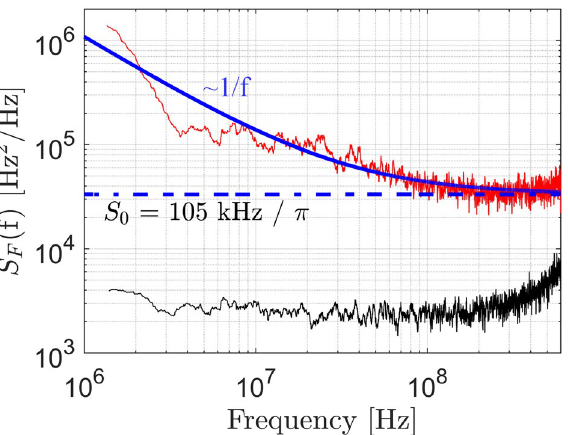
Figure 6. FM-noise spectrum and linewidth measurement. The FM-noise spectrum of the ECL is obtained through heterodyne detection with a narrow-band reference LO laser (Keysight N7714A) and subsequent digital signal processing (red trace). The sampled time-domain waveform comprises 9 × 10 5 points, recorded at a sampling rate of 256 GSa/s. The spectrum is first smoothed by taking a moving average over 50 neighboring points, and then fitted by a model function of the form S F ( f ) = S 0 + S 1 f − 1 (solid blue line). An instantaneous linewidth of δ f = π S 0 ≈ 105 kHz is extracted from the spectrally white part of the FM noise spectrum (dashed blue line). In an independent experiment, we also superimpose the tones of two nominally identical LO lasers and extract the FM noise spectrum for each of these lasers (black trace). This measurement confirms that the FM noise level of the LO laser line is at least one order of magnitude below that of the ECL-LO beat note, thereby supporting the assumption that the extracted Lorentzian linewidth of 105 kHz can indeed be attributed to the phase noise of the ECL for the frequency range considered